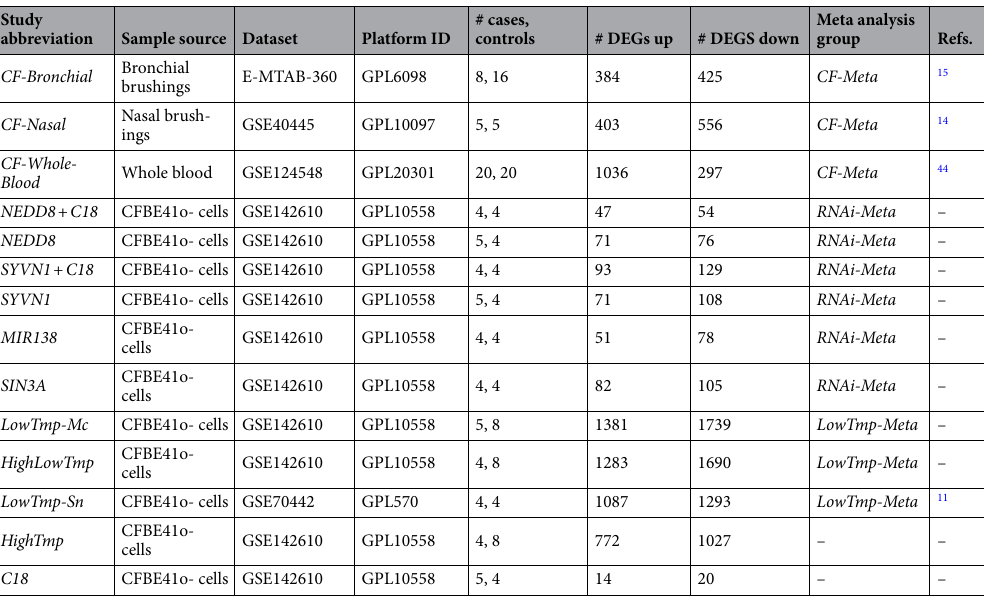
Table 3. Overview of the 14 gene expression studies analyzed in the present work. The Mc and Sn suffixes refer to author names for disambiguation. Add’l additional, Ref reference, Tmp